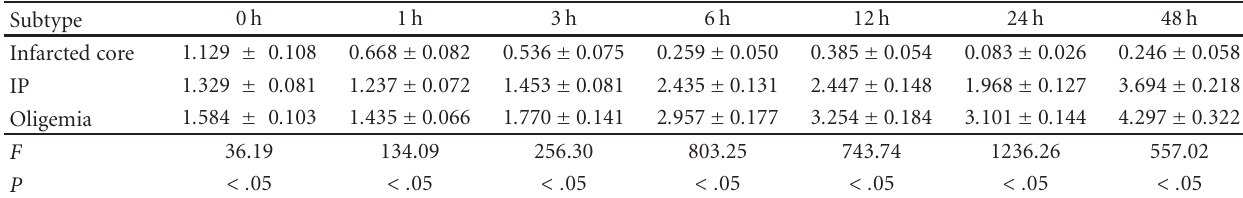
Table 2: Comparison of rR2 (cid:2) ( x ± s ) in infarcted core, IP, and oligemia at each time point after reperfusion.